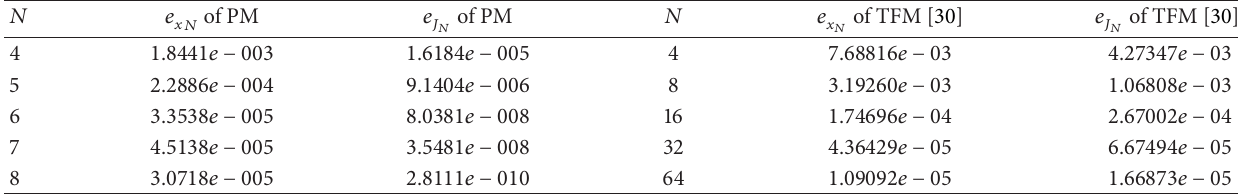
Table 1: Comparison results of Example 3.